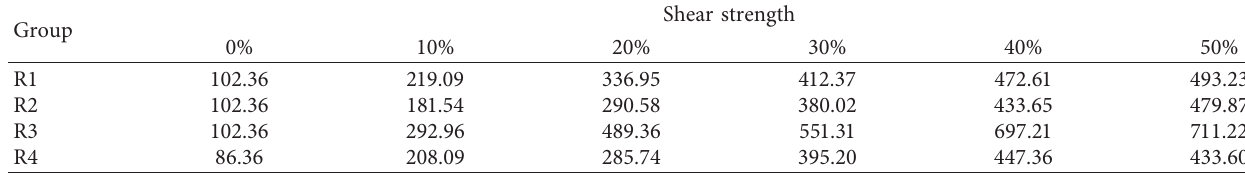
Table 12: Shear strength of asphalt grouting material with different ratio of admixture